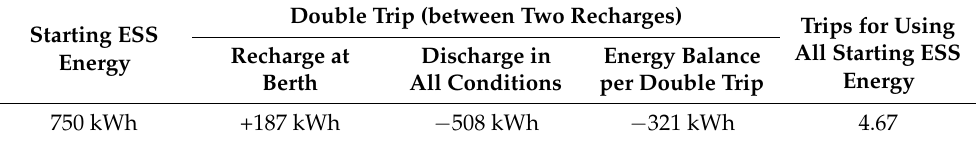
Table 7. Energy balance for case (c).